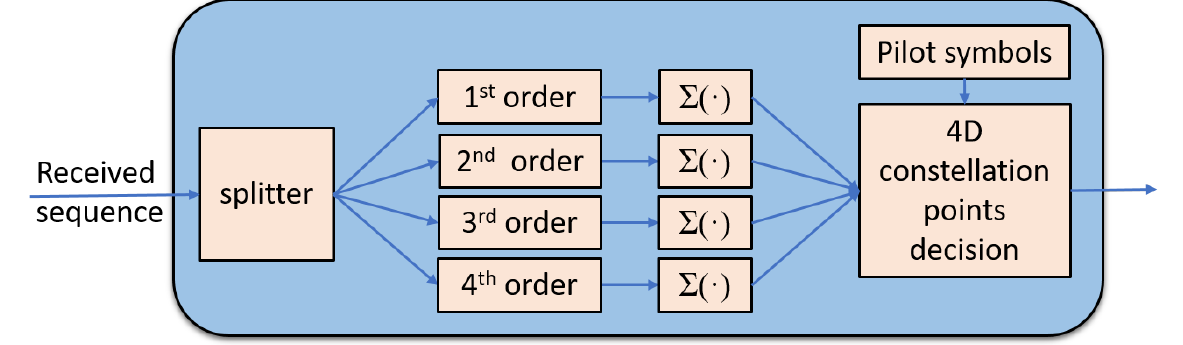
Figure 4. The configuration of the correlation detector.